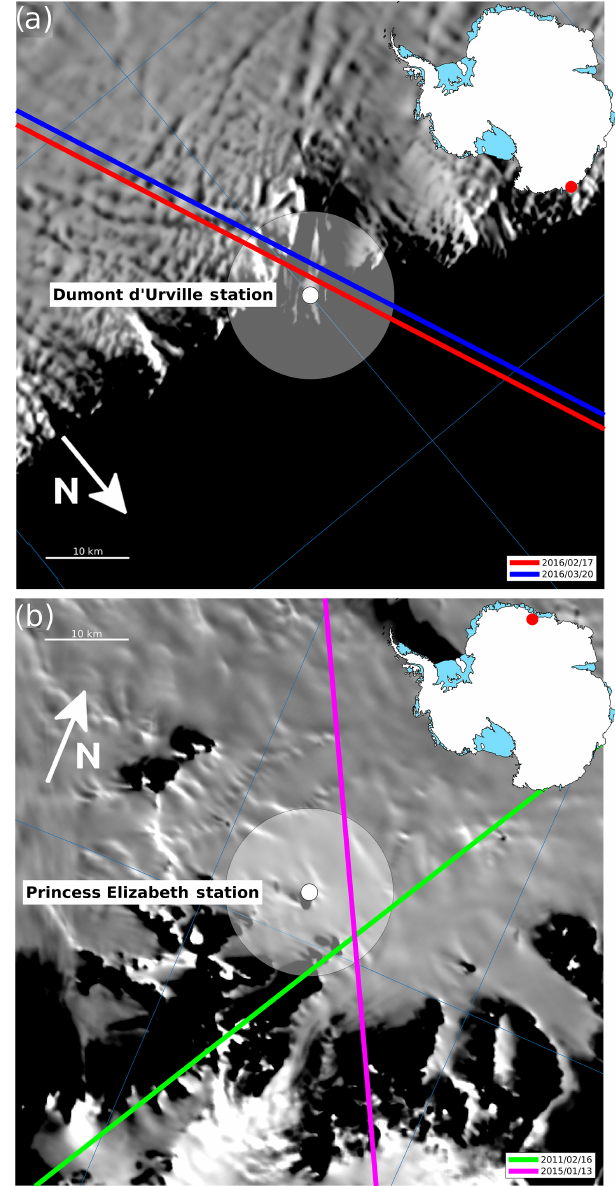
Figure 1. (a) CloudSat radar tracks passing over the French Dumont d’Urville station (DDU) in red for the 17 February 2016 and in blue for the 20 March 2016. (b) CloudSat radar tracks passing over the Belgian Princess Elisabeth station (PE) in green for the 16 February 2011 and in magenta for the 13 January 2015. We only considered the measured profiles passing within a 10km radius represented by a white disc around the stations. The background image is the hill- shaded topography obtained with MODIS MOA2004 (Haran et al.,